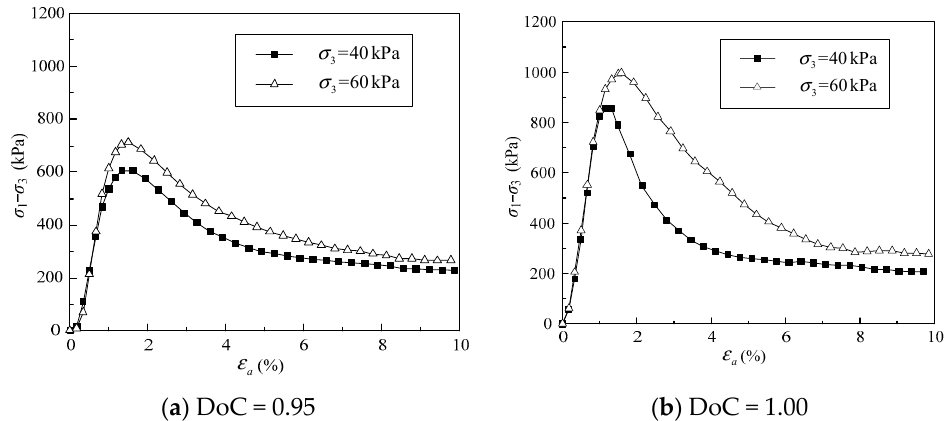
Figure 5. The relationship between deviatoric stress and axial strain for samples with ( a ) DoC = 0.95; and ( b ) DoC = 1.00.